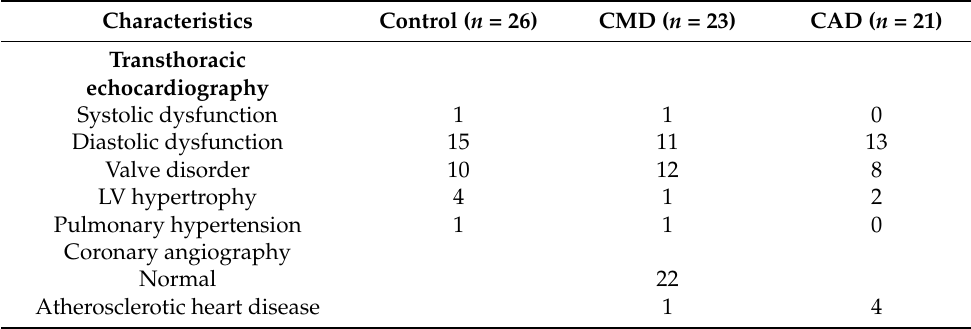
Table 2. Characteristics of patients with CAD or